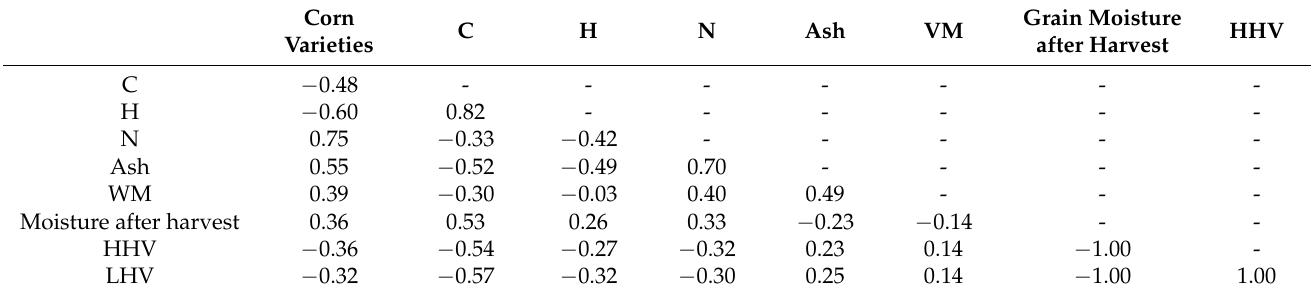
Table 6. Pearson’s correlation coefficients between corn varieties, chemical composition, and heat values. Corn